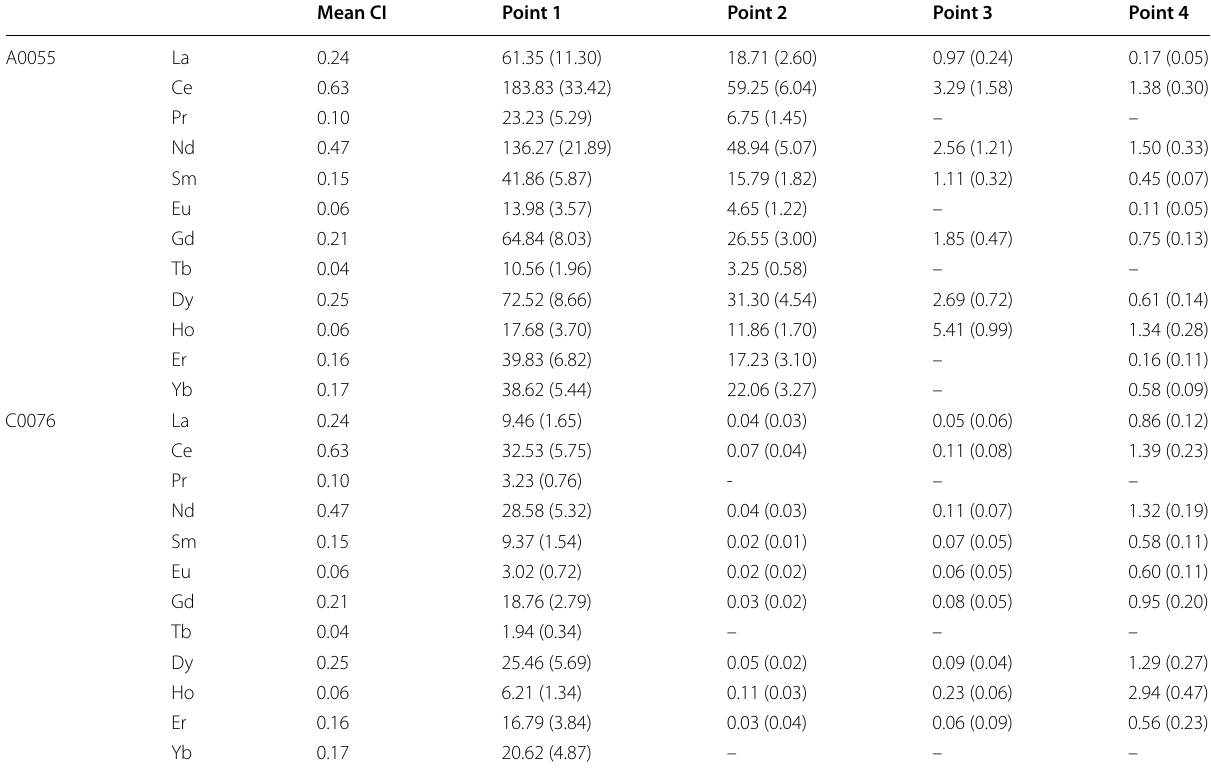
Table 1 Rare earth element concentrations for the separate points of interest, compared to the reported mean CI chondrite (Lodders 2021) concentration